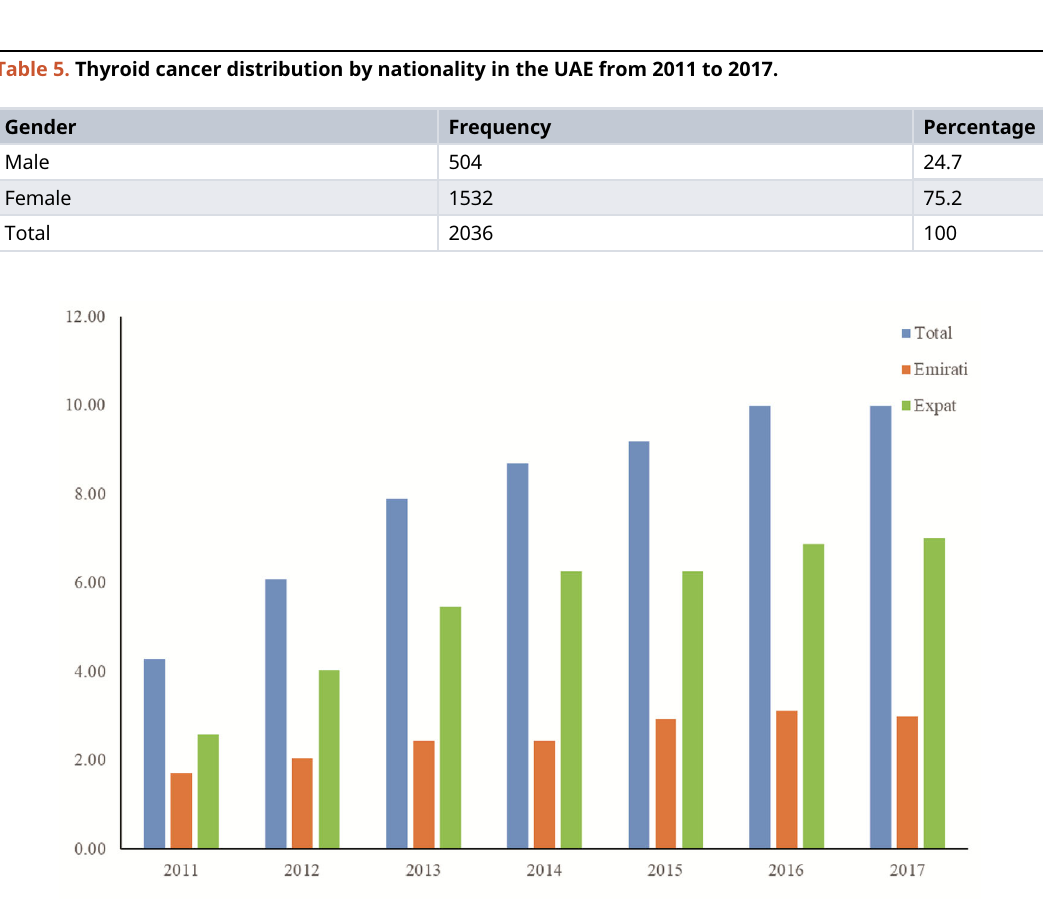
Figure 4. Percentage thyroid cancer demographics within the UAE population.